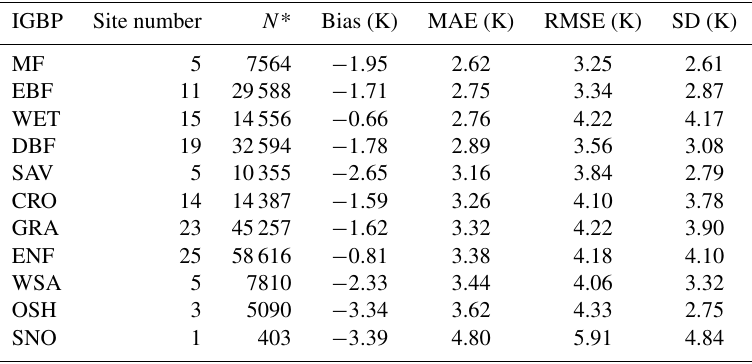
Table 2. Validation results for the GADTC products stratified by IGBP land cover type of the FLUXNET sites.